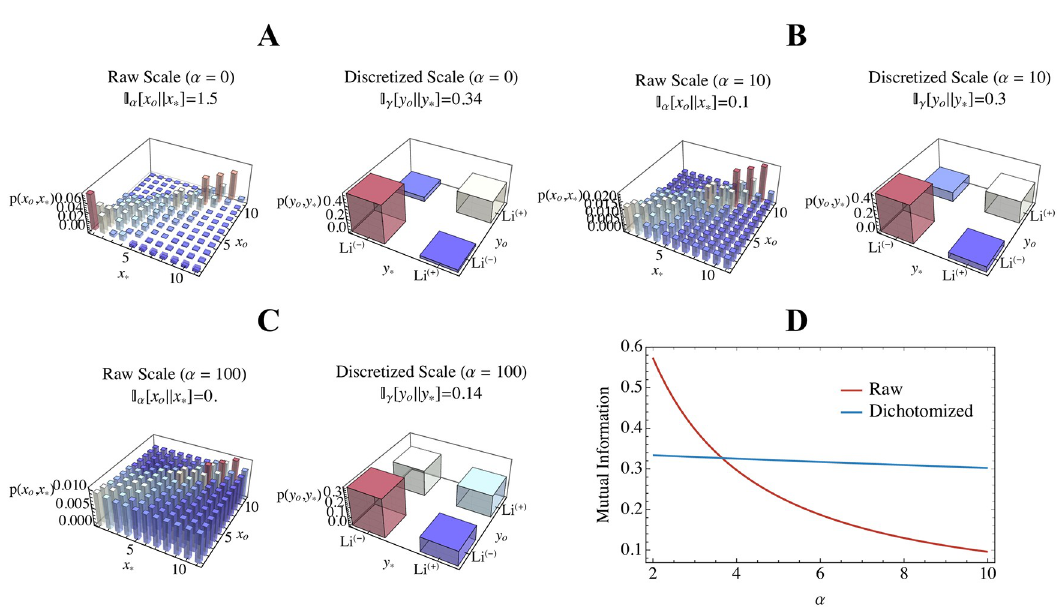
Fig 3. Mutual information between gold standard and observed Alda scores in relation to the observation noise ( α ) and whether the scale is in its raw or dichotomized form (lithium responder [Li(+)] is Alda score � 7; non-responder [Li(-)] is Alda score < 7). Panels A-C show the inferred joint distributions of the observed ( x raw, y � for discrete) values at different levels of observation noise ( α 2 {0, 10, 100}). Panel D plots the mutual information for the raw (red) and discrete (blue) settings of the Alda score across increasing values of α . Recall that here we set ξ = 11/2. https://doi.org/10.1371/journal.pone.0225353.g003 PLOS ONE | https://doi.org/10.1371/journal.pone.0225353 January 27,